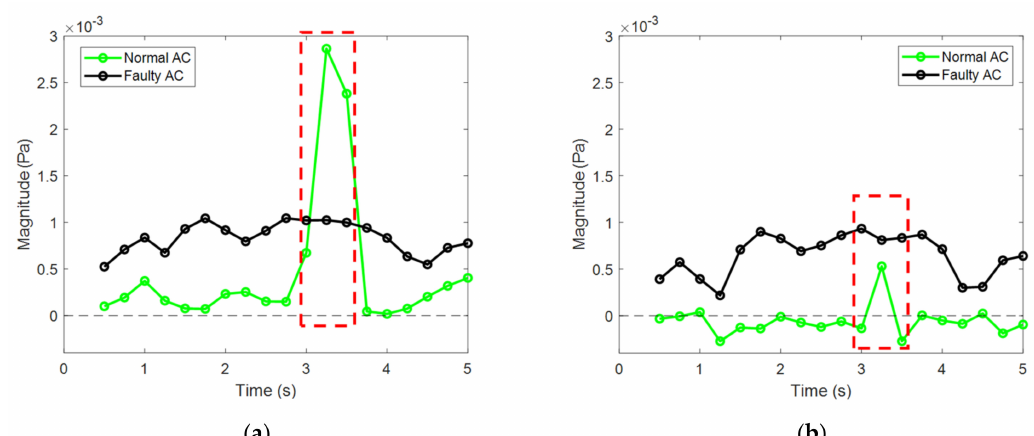
Figure 14. Comparison of detection methods. ( a ) Conventional method using the peak value at the rotational frequency; ( b ) the proposed method using difference between the magnitude at the rotational frequency and the baseline magnitude of the lower